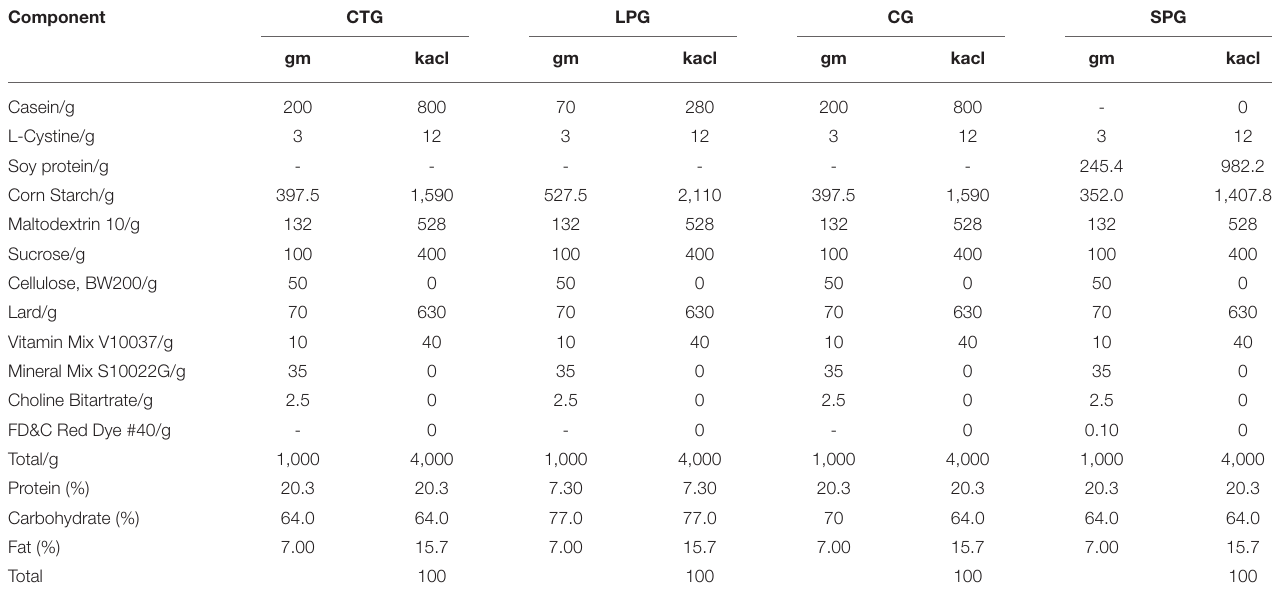
TABLE 1 | The composition of